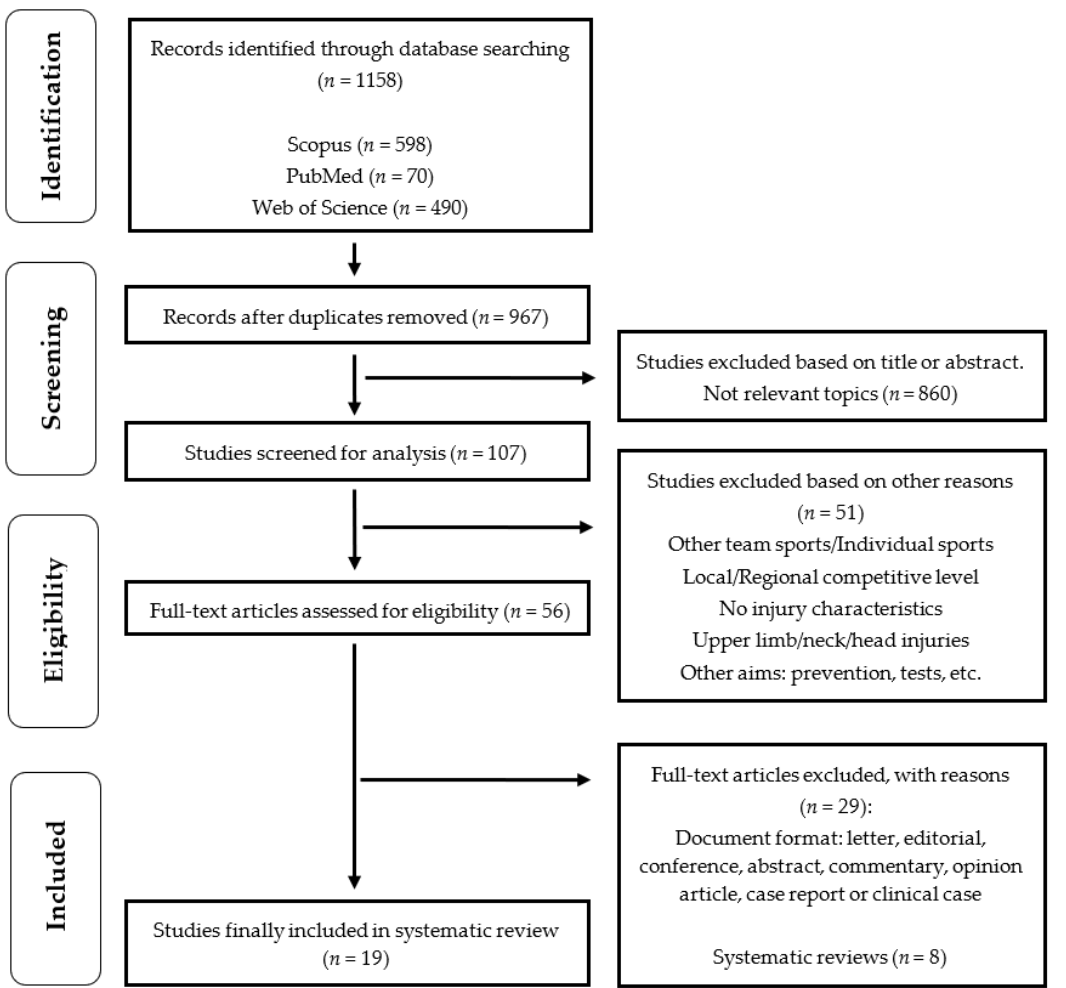
Figure 1. Flow chart for screening and selection according to Preferred Reporting Items for Systematic Reviews and Meta- Analysis